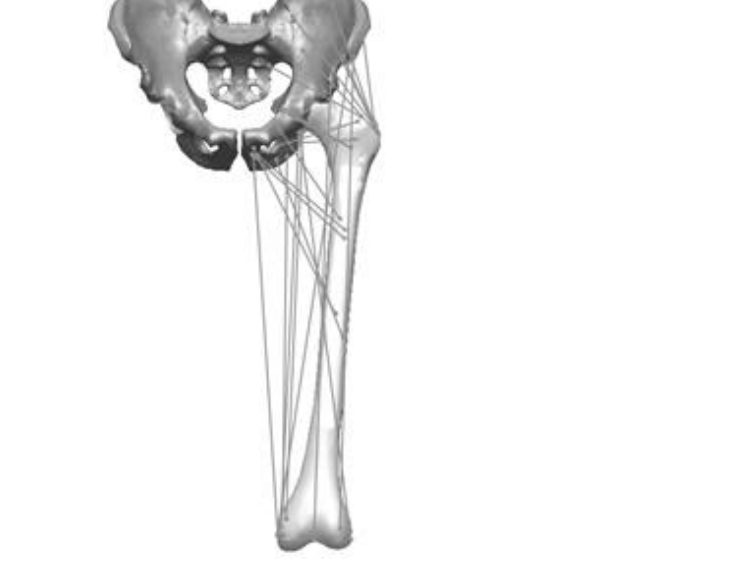
Figure 2 Three-dimensional musculoskeletal computer model of the hip was developed by a computer aided design (CAD). Lines of action for muscle tendon units and the bone geometries are